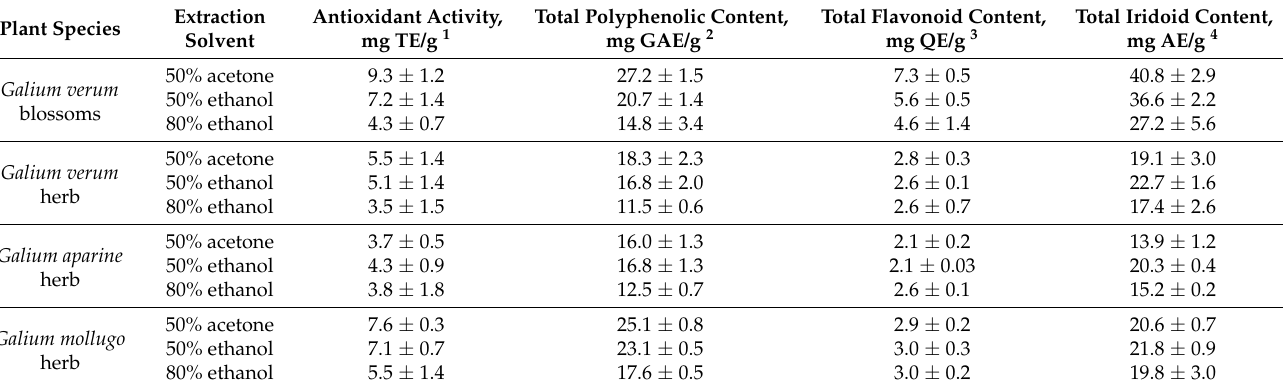
Table 1. Antioxidant activity, and total polyphenolic, flavonoid, and iridoid content of the Galium